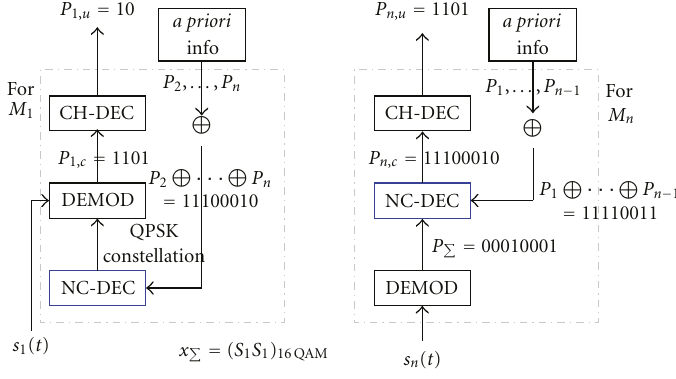
Figure 5: Recover information bits at the nodes.